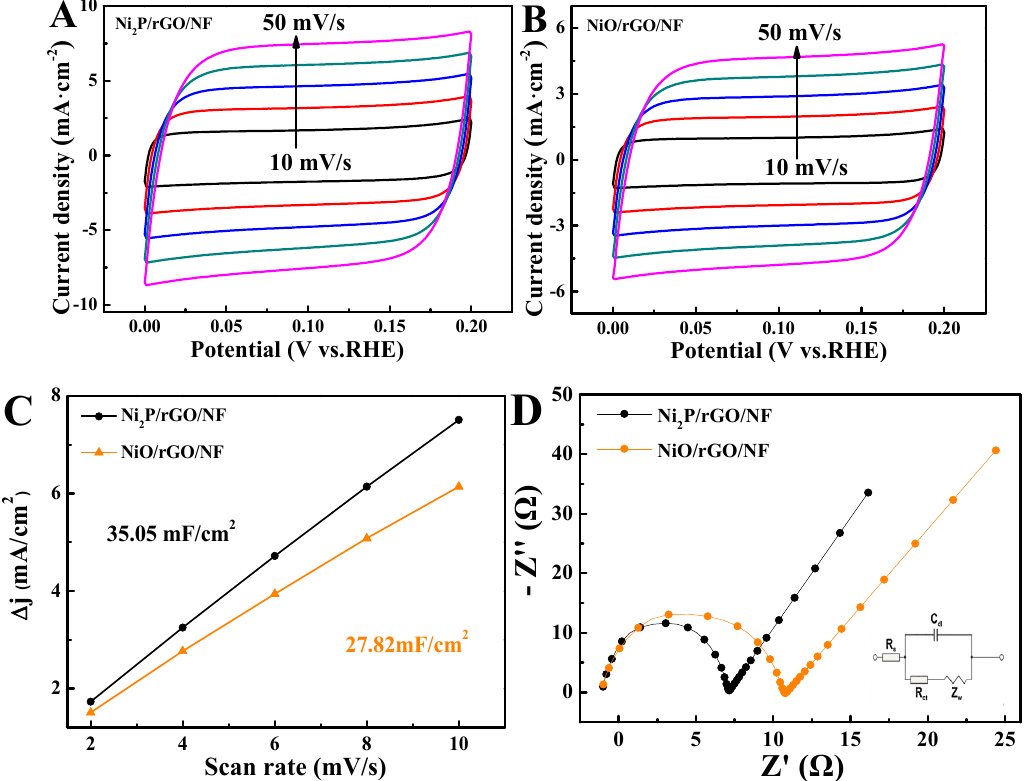
Figure 6. CV of ( A ) Ni 2 P/rGO/NF and ( B ) NiO/rGO/NF. ( C ) A plot of Δ j and ( D ) EIS of Ni 2 P/rGO/NF and NiO/rGO/NF.